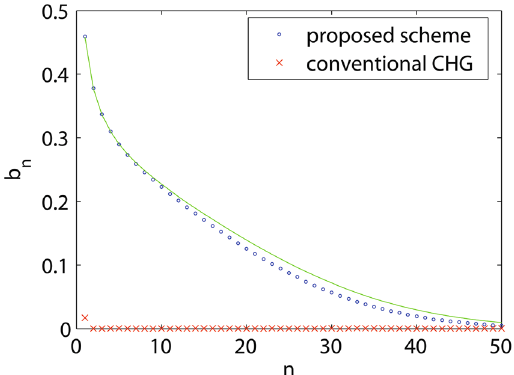
Figure 3. Comparison of the bunching factors of the conventional CHG and the proposed scheme. The red crosses are the results from 3D simulation for the conventional CHG with an energy modulation amplitude of about 0.4 times of the initial beam energy. The green solid curve is the result from the theoretical calculation and the blue dots are the results from 3D simulations for the proposed scheme.